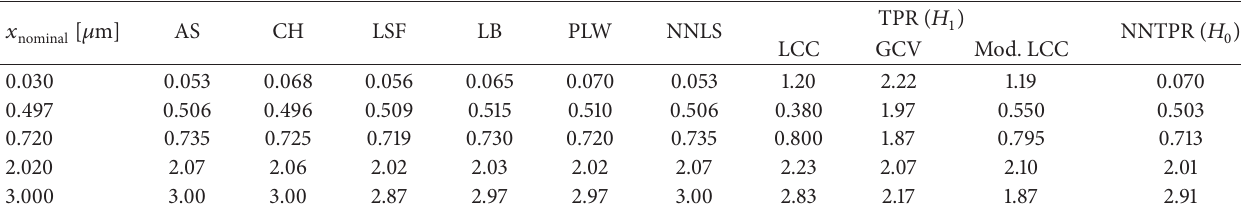
Table 5: Comparison of the retrieved modal particle size x